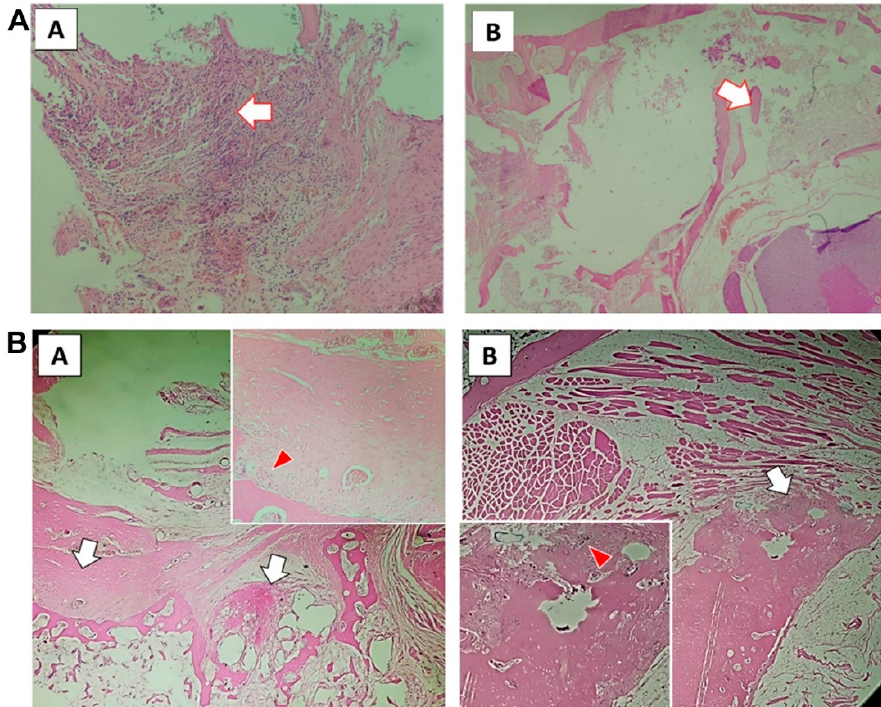
Figure 3. PLGA-PEG-PLGA/CPC composite bone cement promotes the formation of new bone trabeculae in rabbits with osteoporosis: ( A ) 12-week tissue section of PMMA group (A shows the macrophages surrounding the implanted material with obvious foreign body reaction; the arrow in B shows the damaged trabecular bone tissue, with no reconstruction or new bone matrix); ( B ) tissue sections of PLGA-PEG-PLGA/CPC group at 12 weeks (the white arrow in A shows the formation of new bone matrix around the original bone trabecula, with vascular tissue seen in it; the red arrow shows osteoblasts; the white arrow in picture B is the callus around the cortical bone of the vertebral body, with the new bone matrix visible inside; the red arrow is the active osteoblast).